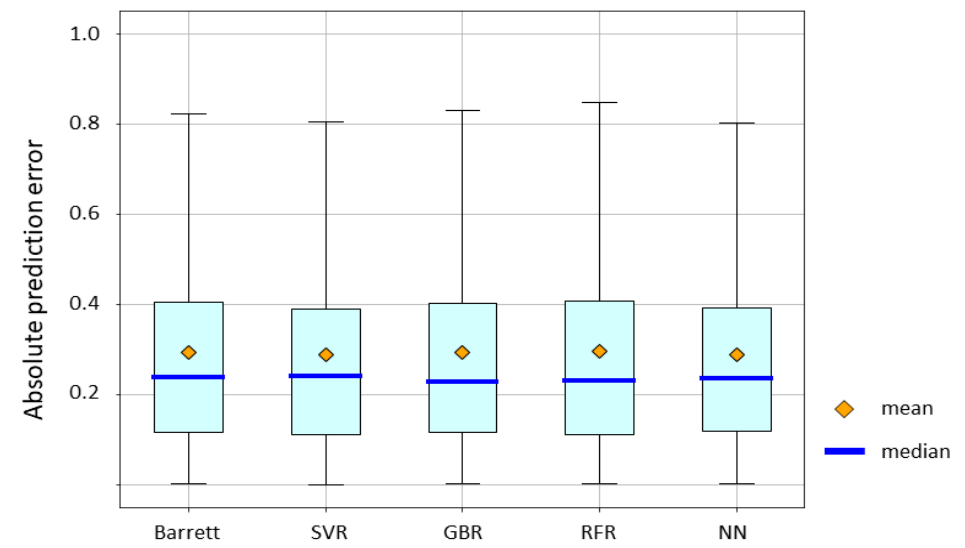
Figure 4. Mean absolute prediction error value of the Barret Universal II formula and machine learning methods. Abbreviations: SVR, support vector regression; GBR gradient boosting regression; RFR, random forest regression; NN, neural network.